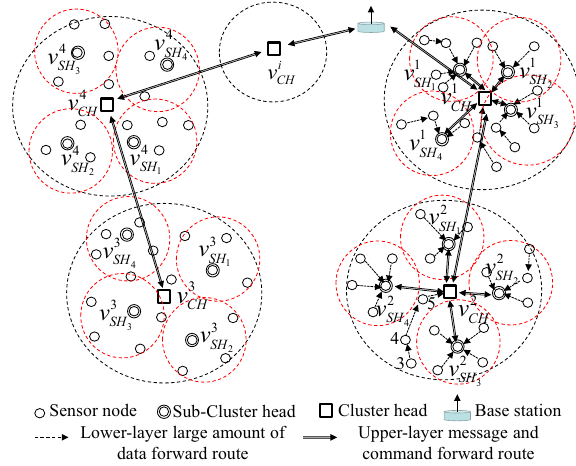
Fig. 4 Cluster and sub-cluster network forming model in the